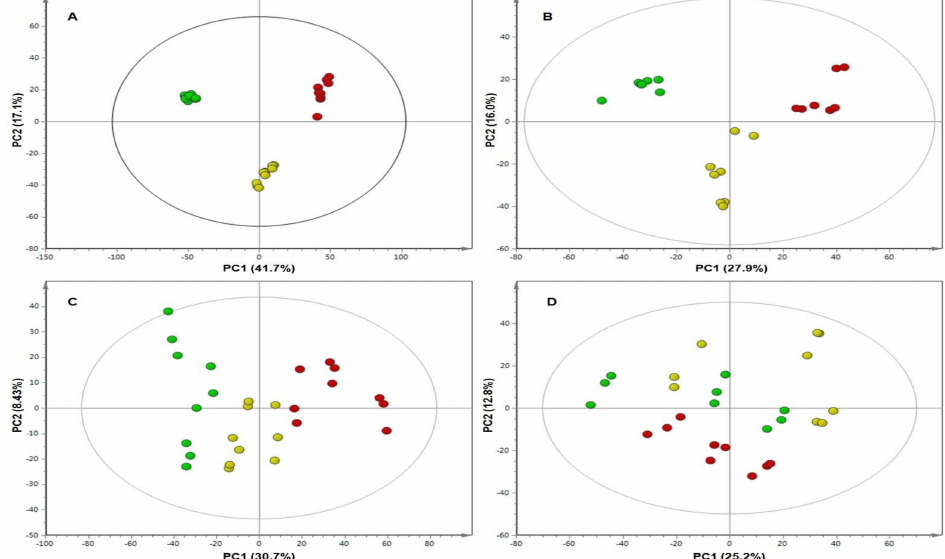
Figure 2. Principal component analysis (PCA) scores plots of negative ionisation data for the resistant ( RT ), tomato plants showing the di ff erential clustering of the three di ff erent treatment groups at ( A ) day 8, ( B ) day 15, ( C ) day 25 and ( D ) day 35. Key: Con , (green); WF , (yellow); WF + Vir (red). PC, principal components.